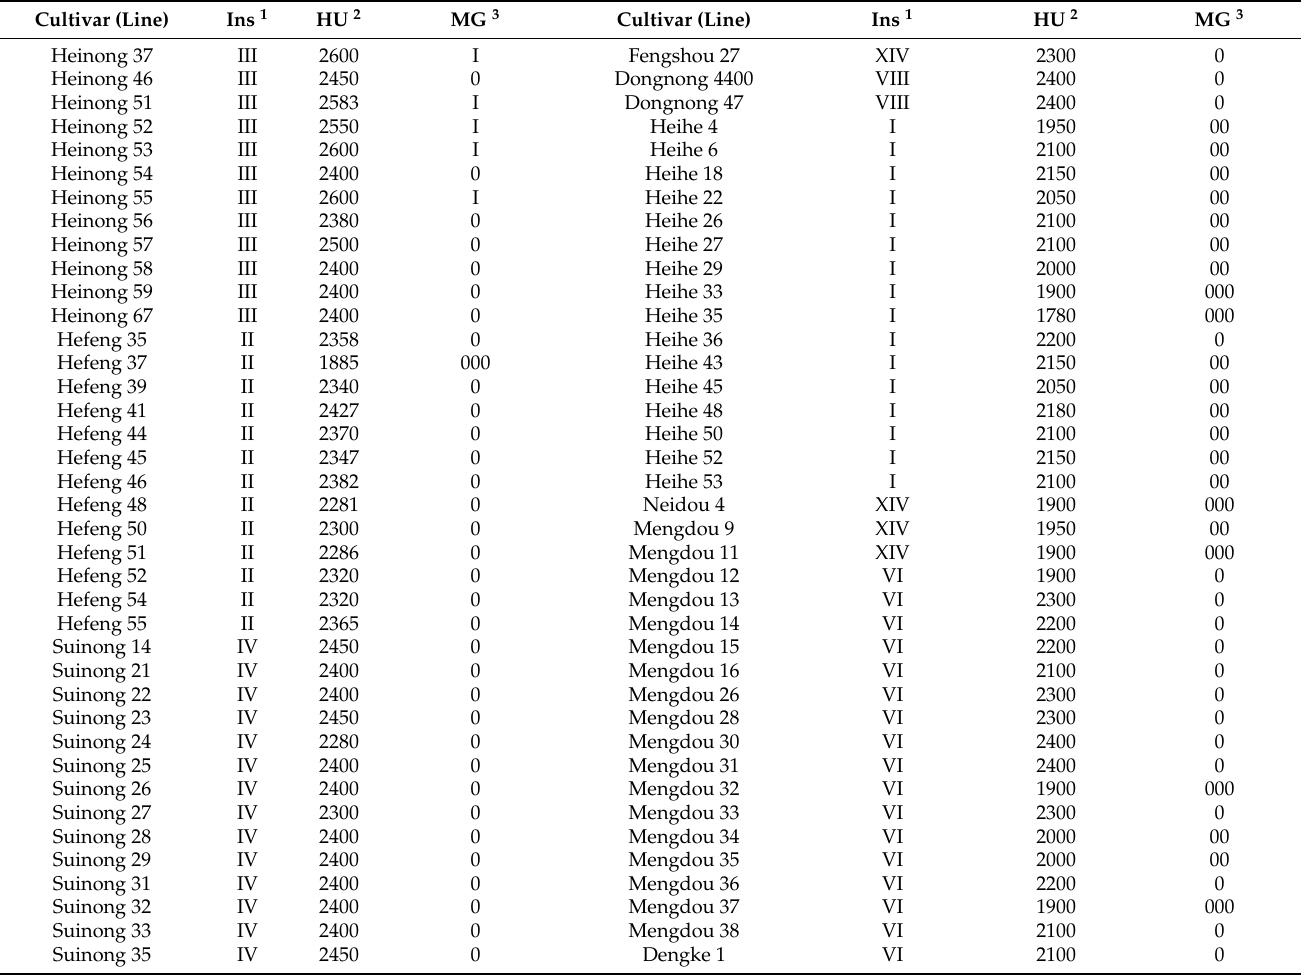
Table 2. Source, maturity group, and heat unit of tested soybean